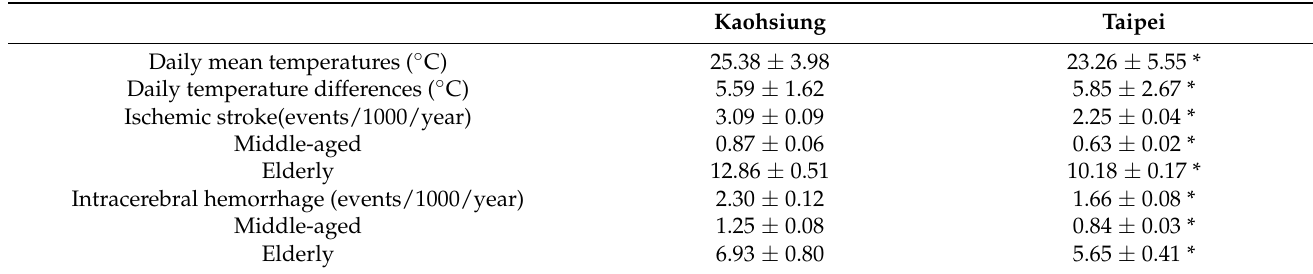
Kaohsiung Taipei